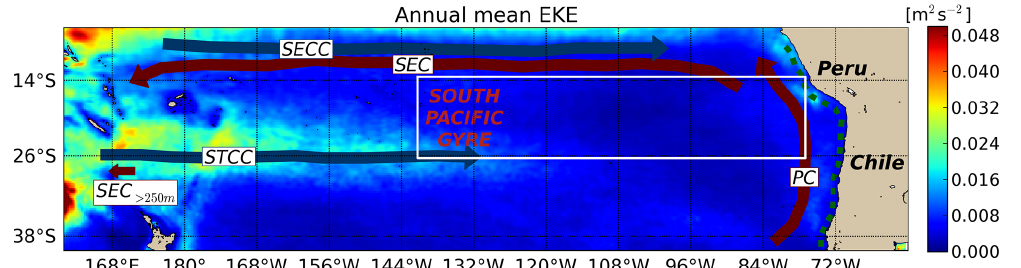
Figure 1. Map of the southeast Pacific. Colors show annual mean eddy kinetic energy (EKE) computed from daily AVISO (DT14, Capet et al., 2014) sea level anomaly data for the period 1993–2013. The white box shows the limits of the area of study. Key: SEC, South Equatorial Current; SECC, South Equatorial Countercurrent; STCC, Subtropical Countercurrent; PC, Peru Current. Green dashed line is the coastal upwelling. The small arrow indicates the poleward extent of the subsurface component of the SEC as observed by Qiu and Chen (2004) between 12 and 30 ◦ S at 170 ◦ E.